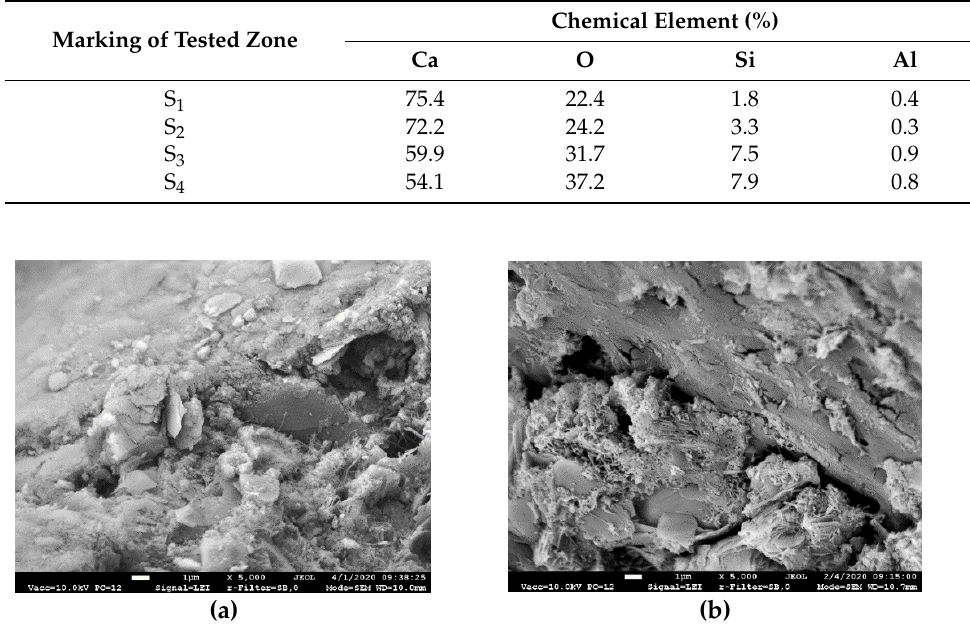
Figure 13. Microstructure of hardened blended cement paste ( a ) with Type A fibers; ( b ) with Type B fibers .